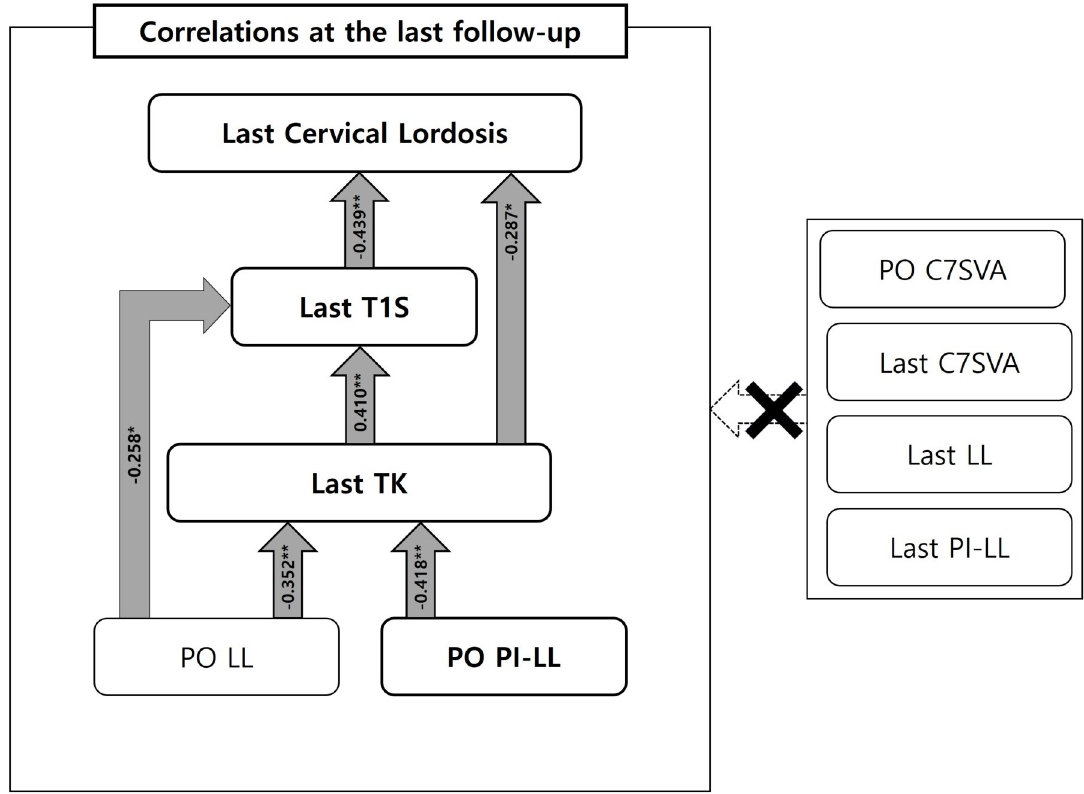
Fig 2. Correlations between Last cervical parameters and the various spinopelvic parameters. Last CL was affected by Last T1S, and Last T1S was affected by Last TK, but both parameters were not significantly associated with Post and Last C7SVA, Last LL and Last PI-LL. Additionally, there was a significant association between Last TK and Post